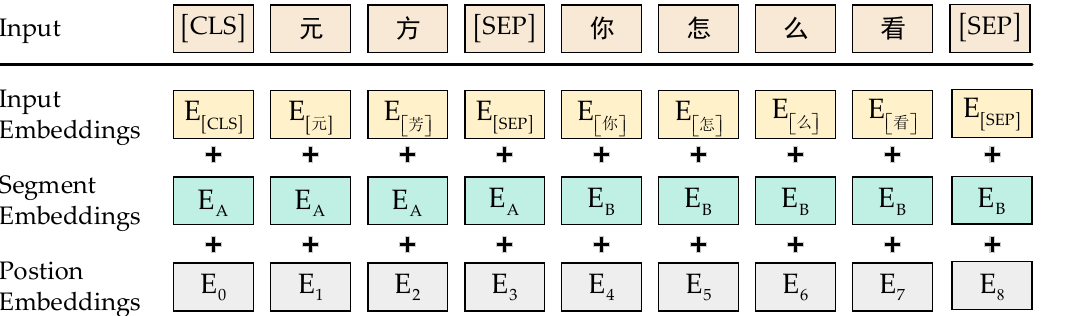
Figure 3. Input characterization diagram of BERT.( The intput ” 元芳，你怎么看 ” is translated as “Yuan Fang, what do you think”.)